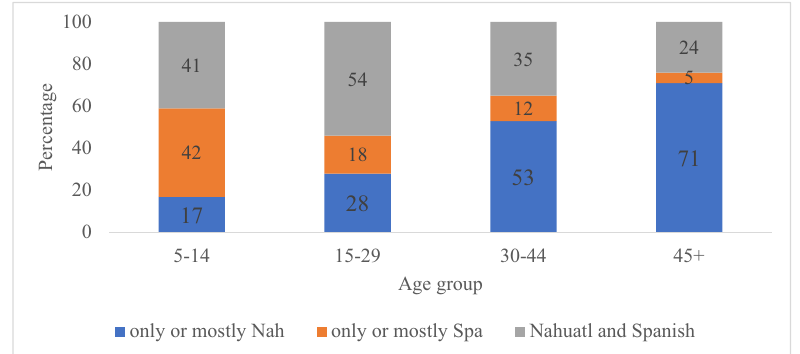
Figure 1: Home language use by age